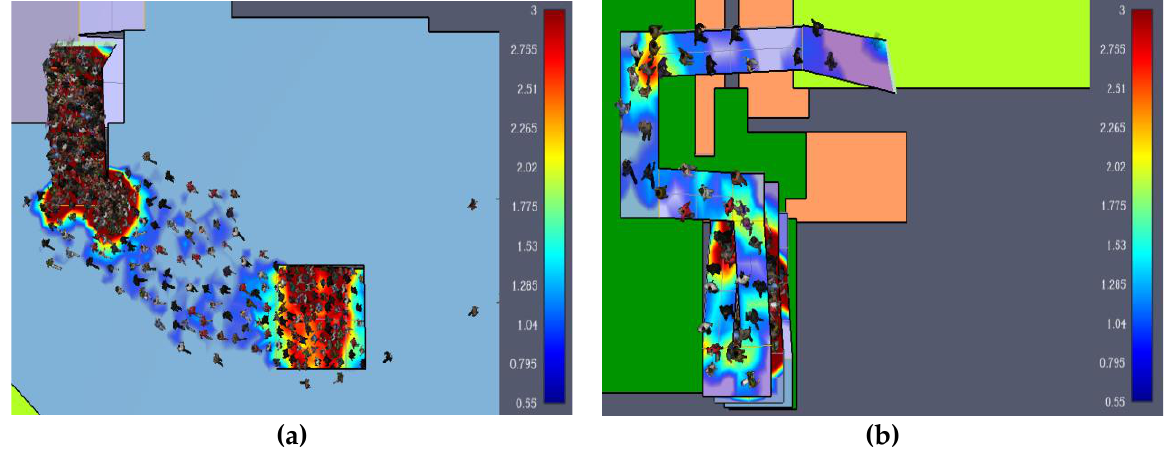
Figure 13. ( a ) Evacuation in platform 5 ; ( b ) Evacuation in Station hall floor.